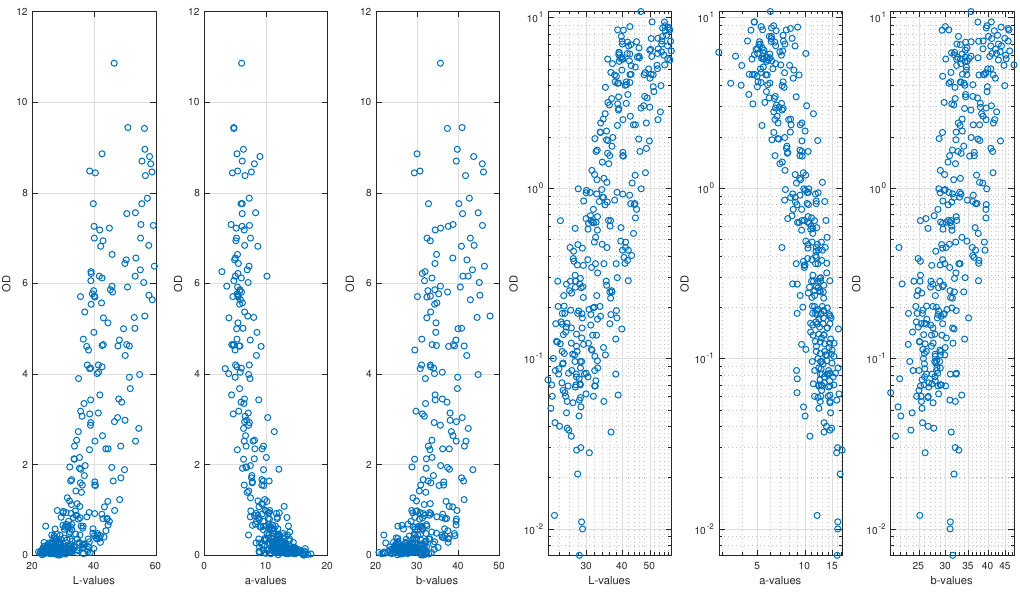
Figure 6. Relationship between optical density (OD) and colour components of all experiments. The three panels to the right depict values in the log-space.